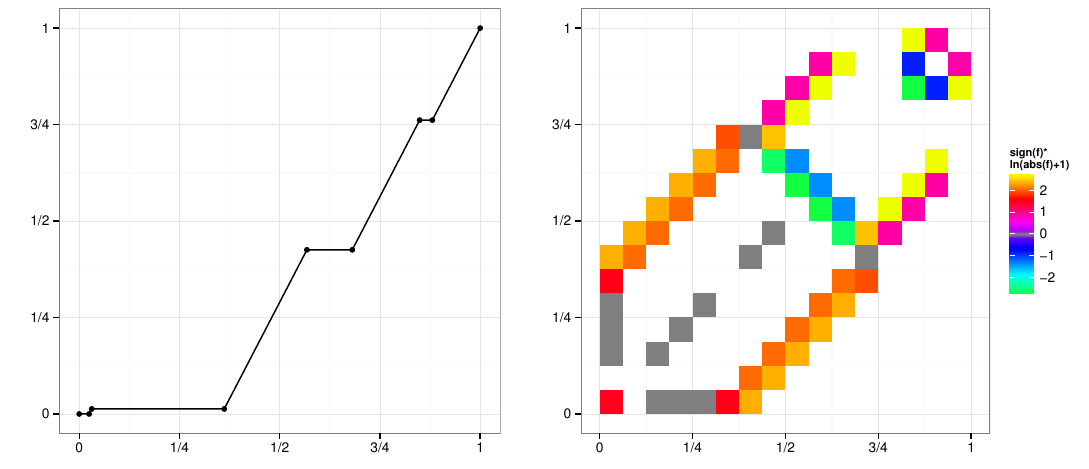
Figure 3: Diagonal δ (left) and density f (right) of W A δ 4 ( Π ) , with A δ according eq.